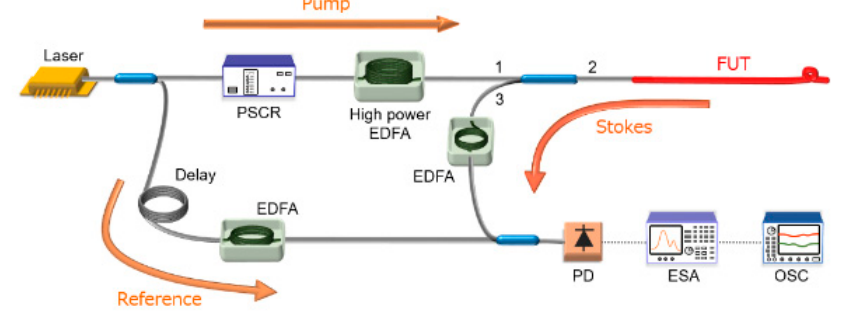
Figure 1. Experimental setup of SA-BOCDR. EDFA, erbium-doped fiber amplifier; ESA, electrical spectrum analyser; FUT, fiber under test; OSC, oscilloscope; PD, photo diode; PSCR, polarization scrambler.